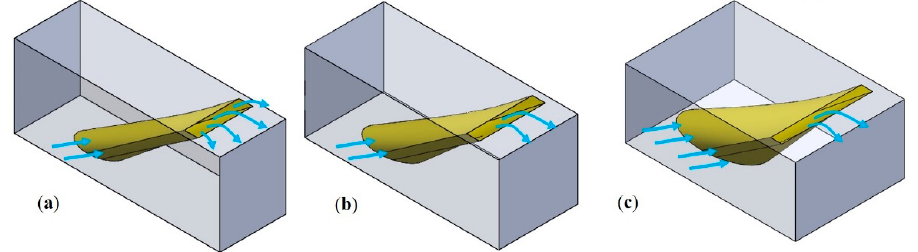
Figure 3. Schematic diagram of typical RTSH model: ( a ) expansion hole; ( b ) reference hole; ( c ) convergence hole.